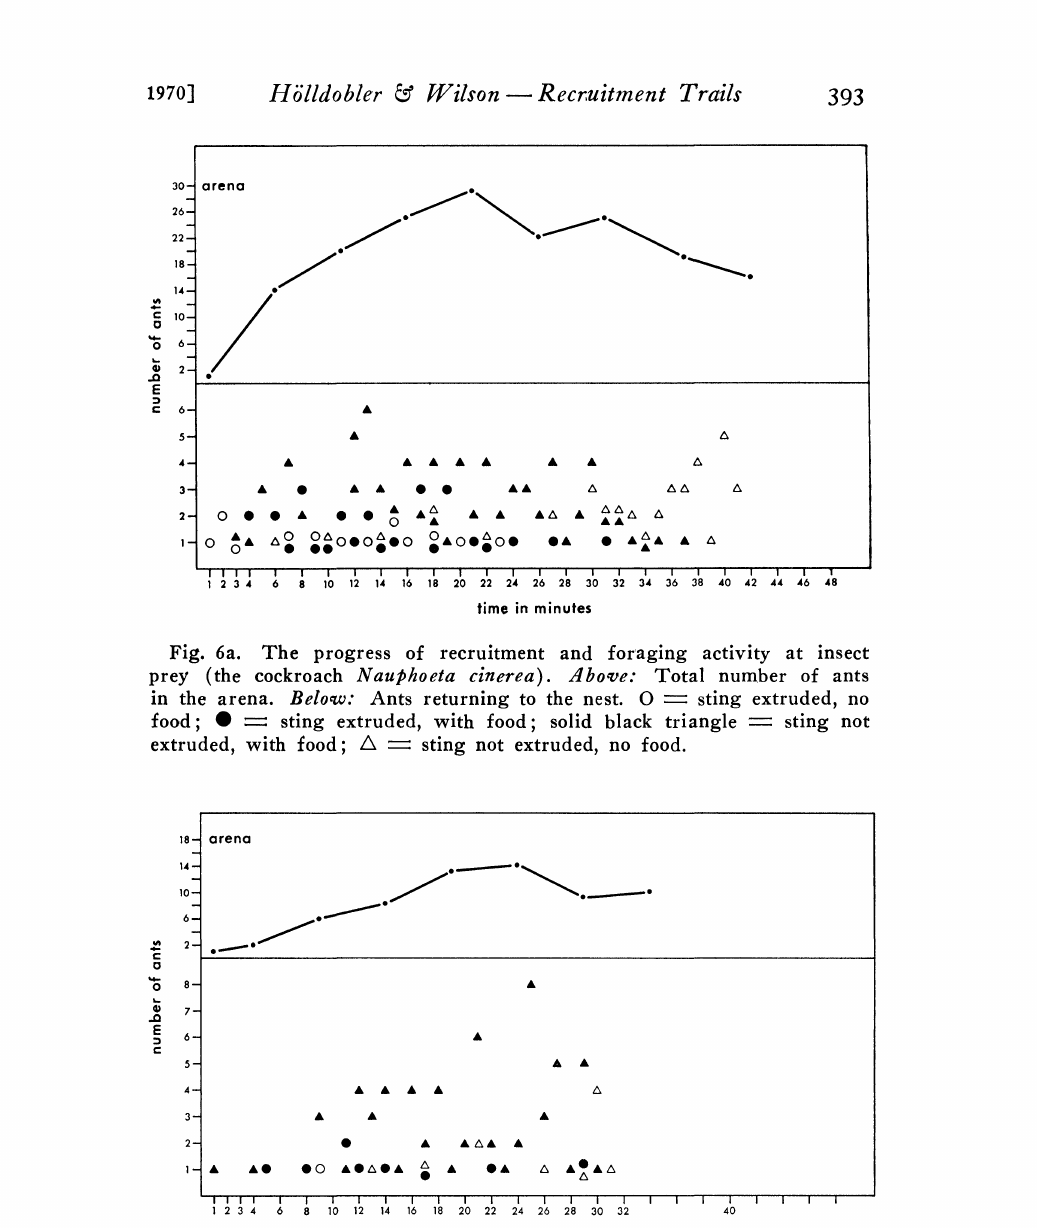
Fig. 6b. The progress of recruitment and foraging activity at oak flakes at one spot. Details as in caption of fig.